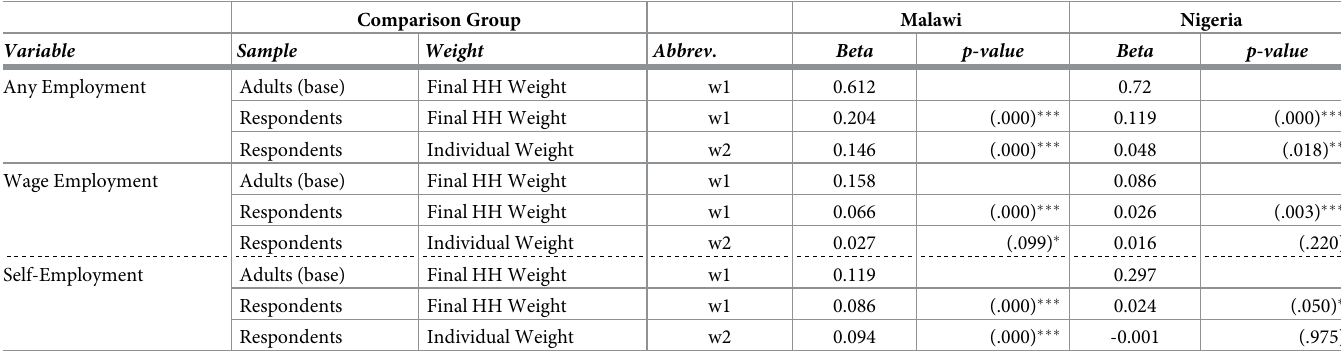
the HFPS respondents versus the general adult population for wage employment and for self- employment, except among individuals aged 25–49 where a significant difference remains for wage employment. The differences in overall employment variable remain significant among the male sub-population, and individuals aged 25–49 in Nigeria, which are the largest sub- populations of HFPS respondents. In Malawi, the individual-weighted estimates for the HFPS respondents are statistically indistinguishable from the benchmark estimates for wage employ- ment among males and for overall and wage employment among individuals aged 25–49. The Table 6. Differences in HFPS round 5 employment outcomes between phone survey respondents and adult